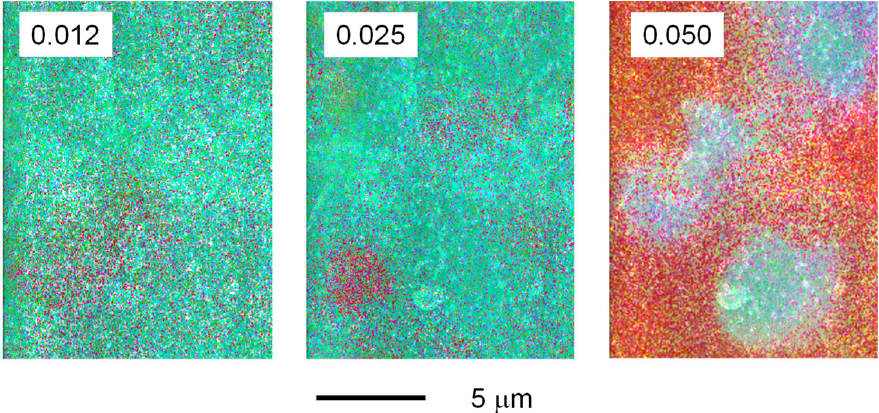
Figure 3. Energy-dispersive X-ray spectroscopy images of the films containing MgSO 4 . The numerals in the figure represent the molar ratios of MgSO 4 .